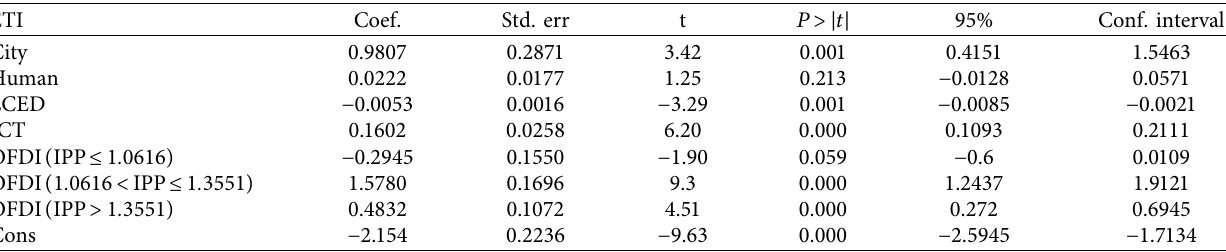
Figure 2: The construction of confidence intervals. (a) The first threshold value. (b) The second threshold Table 4: Model parameter estimation result.